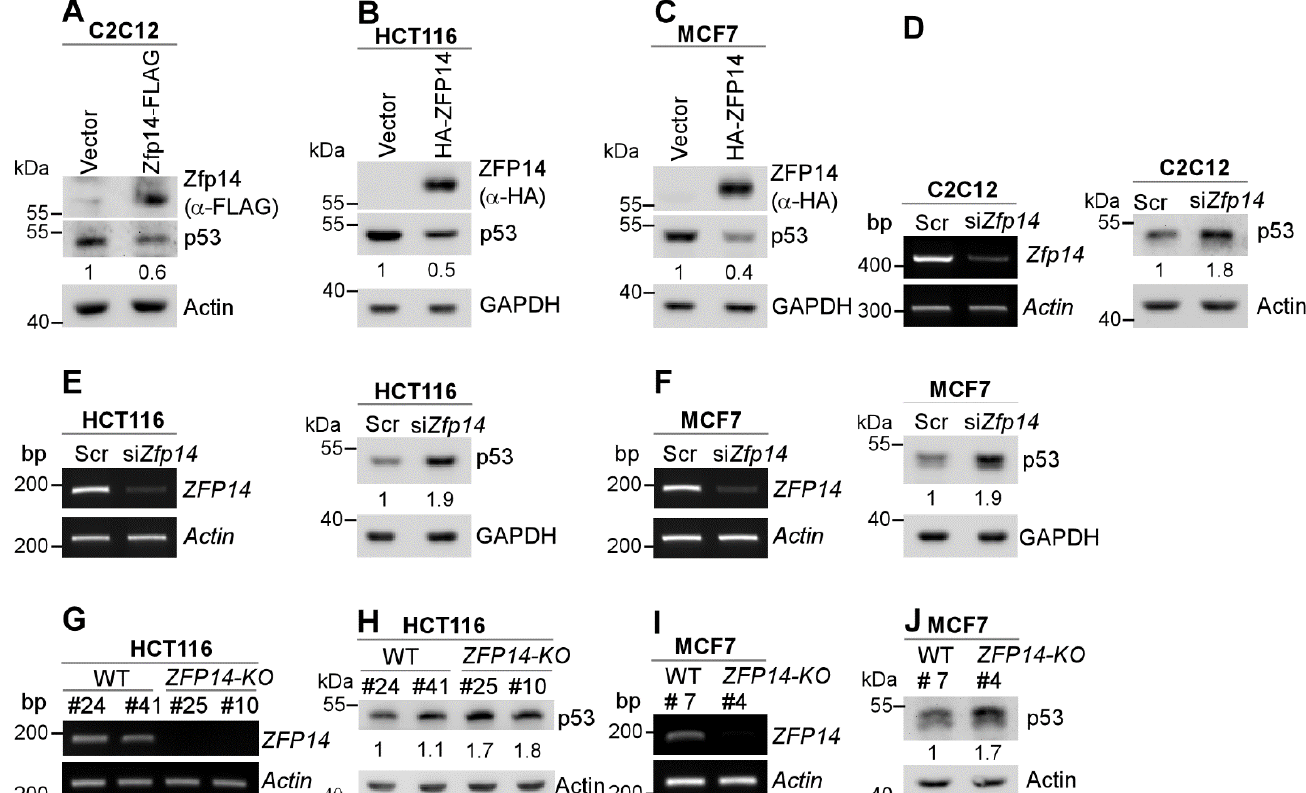
Figure 2. Human and mouse ZFP14 negatively regulate p53. ( A – C ) ZFP14, p53 and actin/GAPDH protein levels were measured by Western blotting in mouse C2C12 ( A ), human HCT116 ( B ) and human MCF7 ( C ) cells transiently transfected with either empty vector, mouse Zfp14 ‐ FLAG ( A ) or human HA ‐ ZFP14 ( B , C ) for 24 h. ( D – F ) The levels of ZFP14 and actin mRNAs (left panels) or p53 and GAPDH/actin proteins (right panels) were measured in mouse C2C12 ( D ), human HCT116 ( E ) and human MCF7 ( F ) cells that were transfected with 75 nM scramble or ZFP14 siRNA for 72 h. ( G , I ) The levels of ZFP14 and actin mRNAs were measured in isogenic controls and ZFP14 ‐ KO HCT116 (clones #25 and #10) cells ( G ) or isogenic control and ZFP14 ‐ KO MCF7 (clone #4) cells ( I ). (H, J) The levels of p53 and actin proteins were measured in isogenic controls and ZFP14 ‐ KO HCT116 (clones #25 and #10) cells ( H ) or isogenic control and ZFP14 ‐ KO MCF7 (clone #4) cells ( J ).